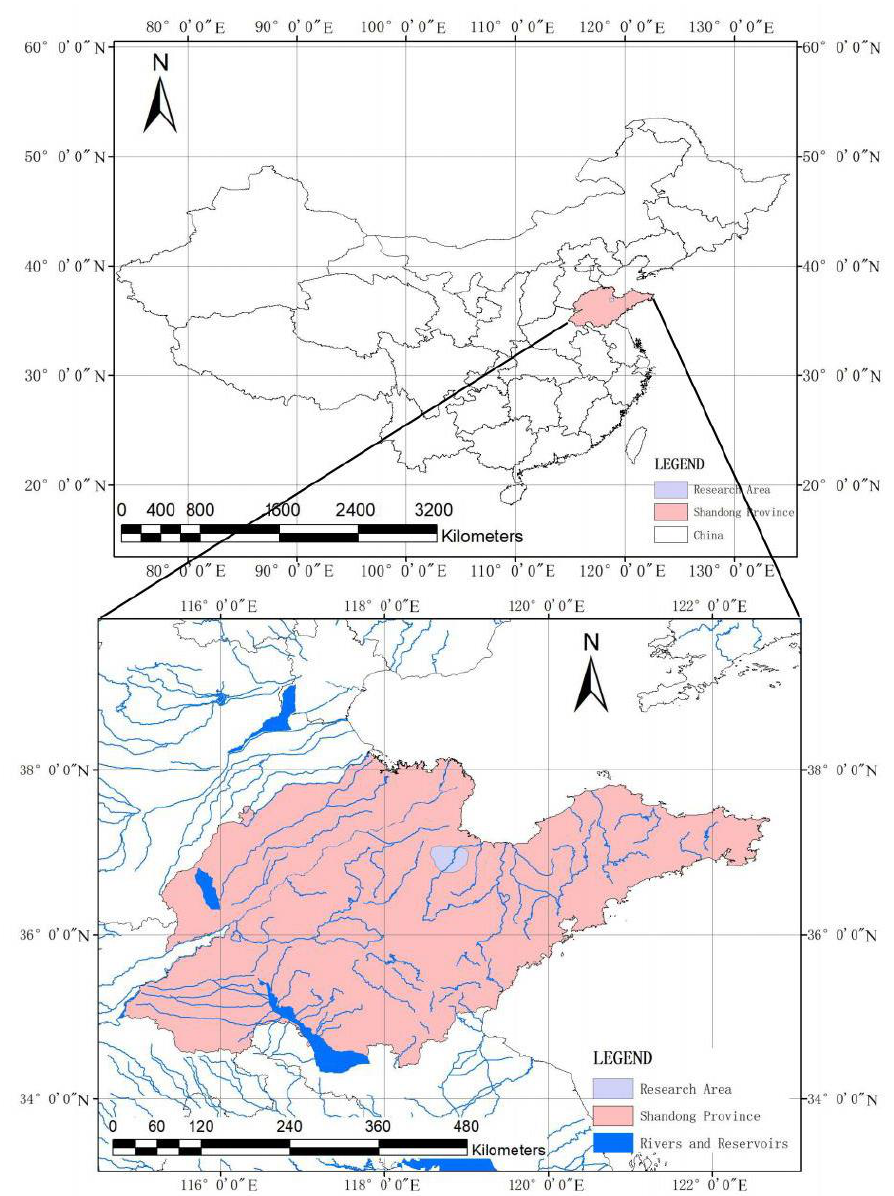
Figure 1. Location map of the study area.